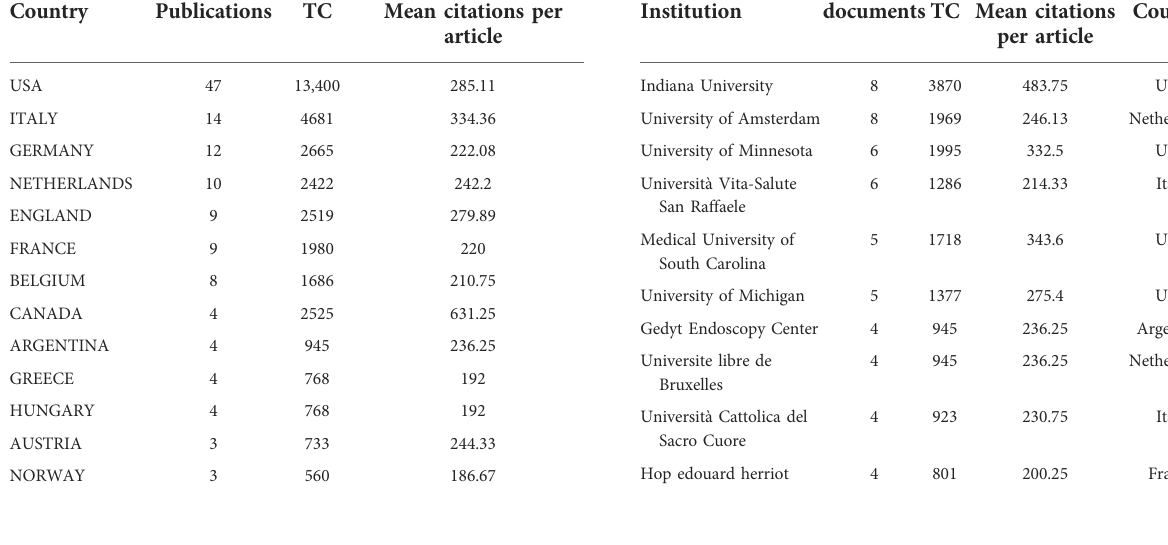
TABLE 3 First, senior, or corresponding authors who have published at least fi ve T100 articles. TC=Total